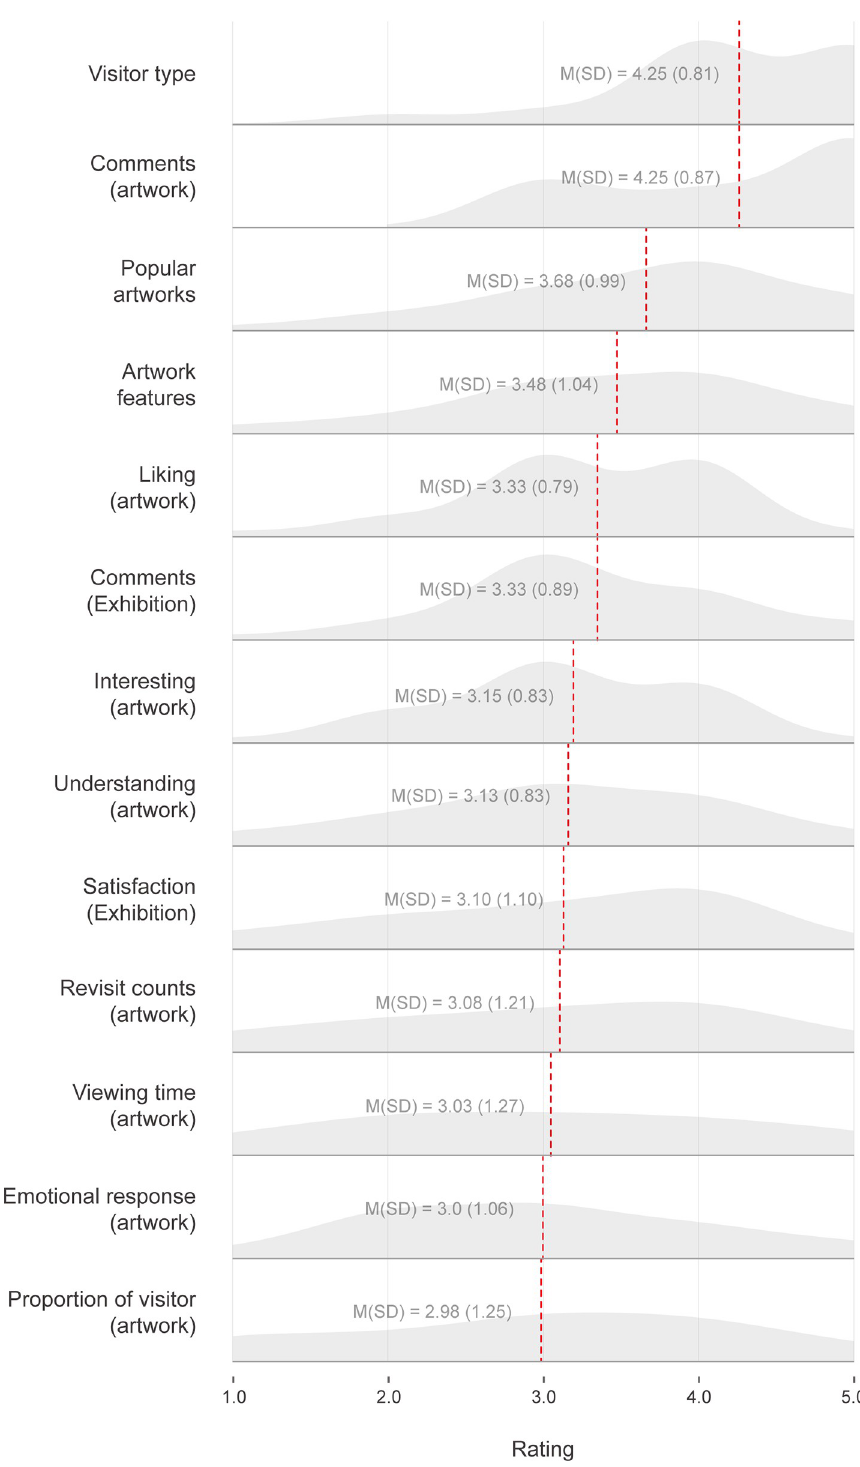
Fig 8. Ridge plot of visitor ratings for VSCI elements (drawn in the order of average scores [highest to lowest], depicted by the red lines). VSCI represents “visitor-based social contextual information”.